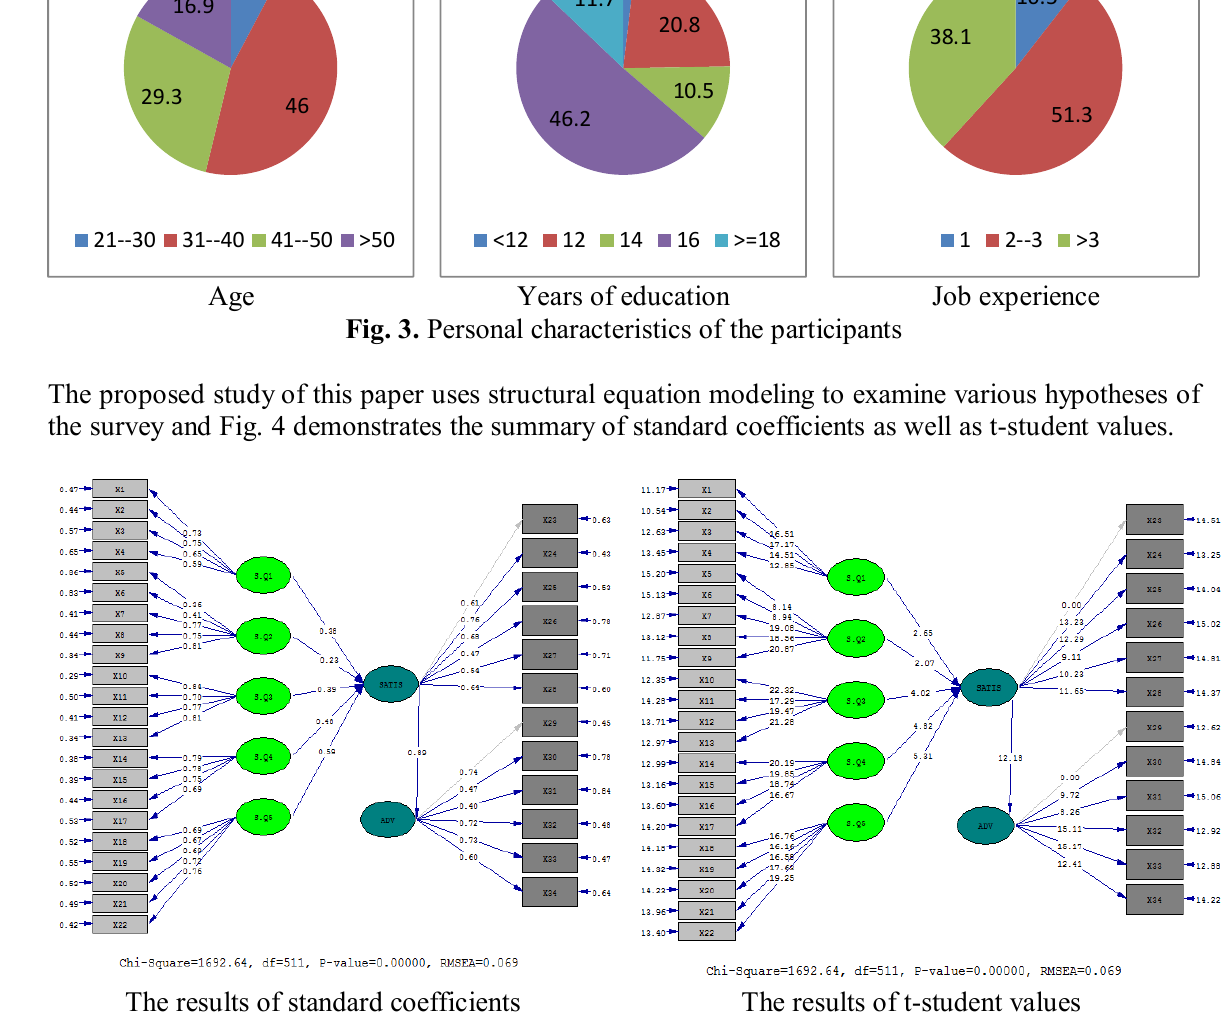
Fig. 4. The summary of standard coefficients as well as t-student values